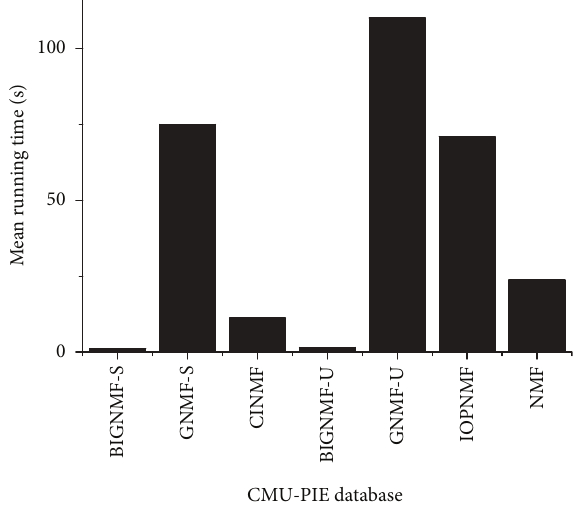
Figure 8: The mean running time during incremental study with images belonging to one class for the CMU-PIE